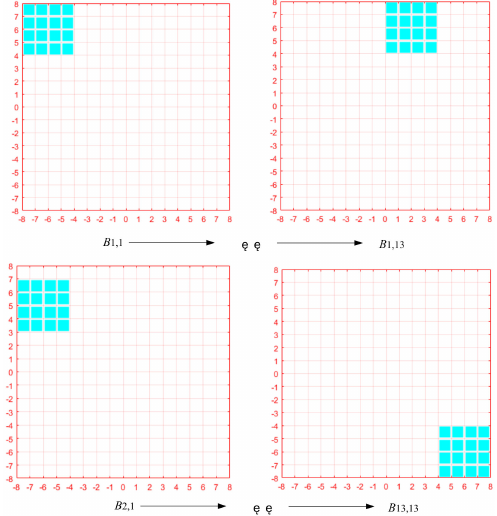
Figure 2. Exhaustive search method Search